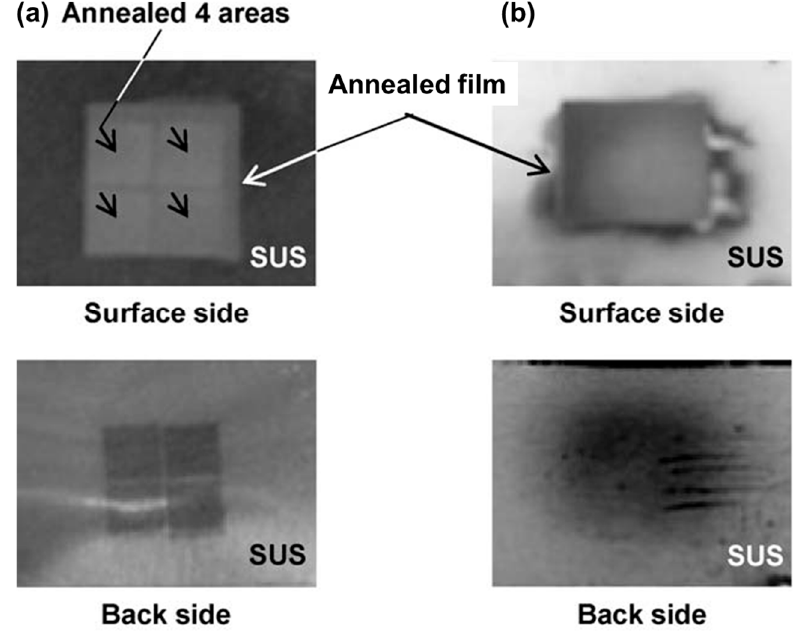
Figure 10. Photographs of top and bottom surfaces of PZT / stainless-steel substrate (STS) system annealed using ( a ) fiber laser (FL) and ( b ) CO 2 laser irradiations [27]. © Copyright 2009, Appl. Surf. Sci.